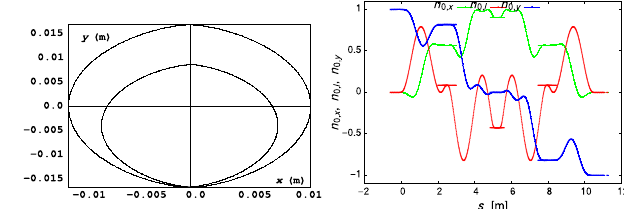
FIG. 31. Along RHIC Yellow 3 o ’ clock snake, case of I ¼ 164 A, I ¼ 221 A: ϕ ¼ 0 ° and μ ¼ 180 °. Left: trans- out in verse projection of the helical motion. Right: spin components, case of initially vertical